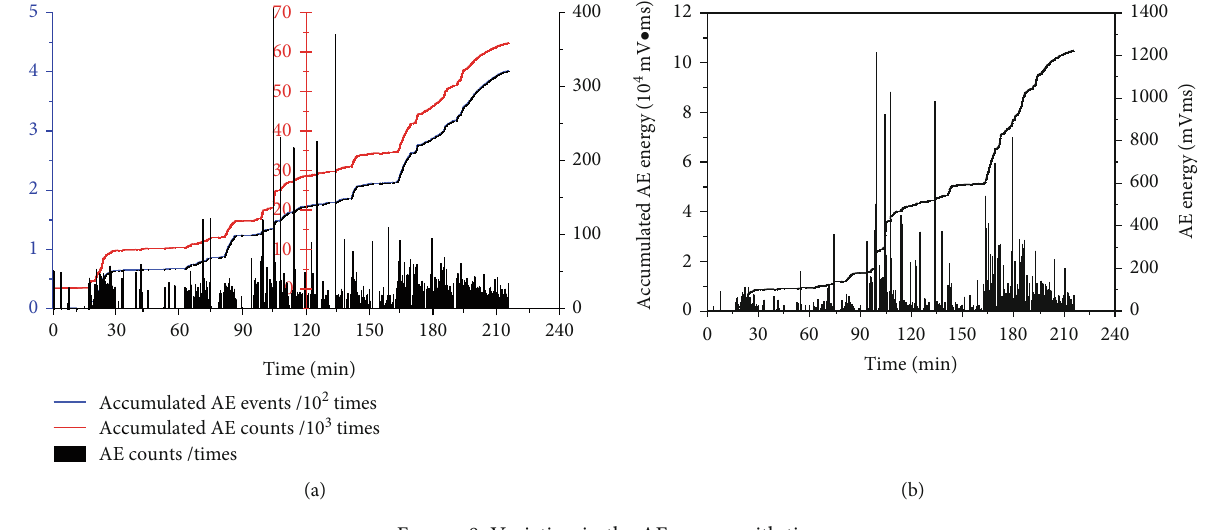
Figure 8: Variation in the AE energy with